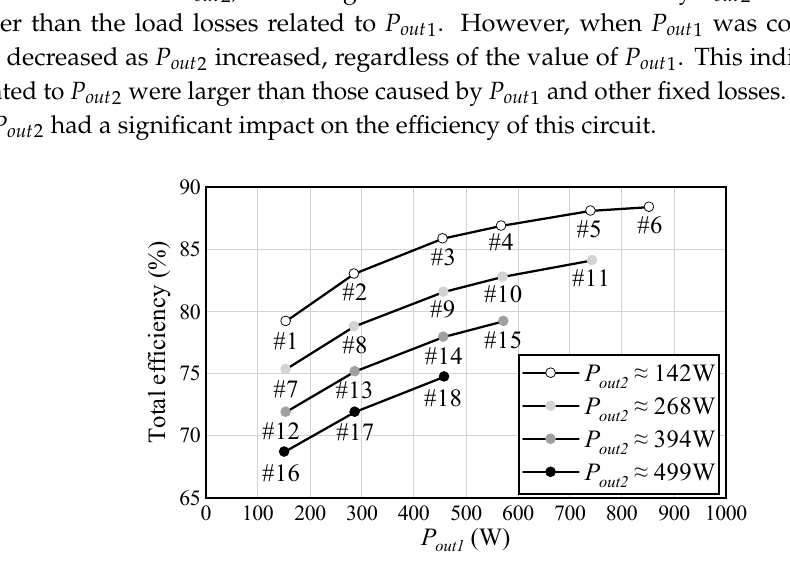
Table 6. Loss calculations.